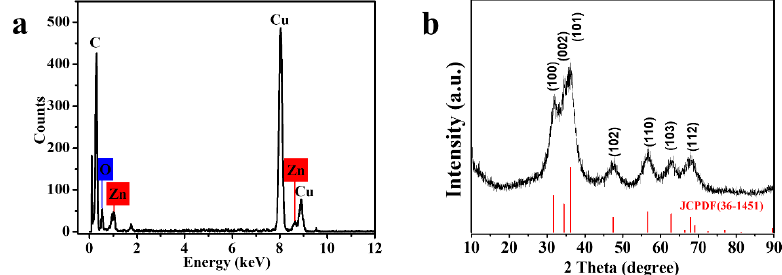
ff raction (WAXRD) of ZnO QDs.